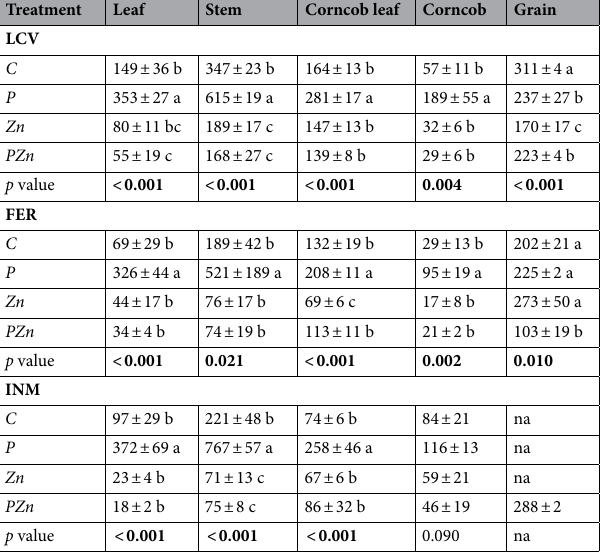
Table 3. Phosphorus to zinc mole ratio for each plant part of the maize crop at harvest (mean ± standard error, n = 4 except for grain in INM, where n = 2) as a function of treatment for each soil. Significant p values are in bold to indicate significant differences. p is the probability level of the one-way ANOVA. Different letters indicate significant differences among treatments according to the post-hoc LSD test. C : no P or Zn was added; P : fertilization with 40 mg P kg −1 but no Zn; Zn : fertilization with 3 mg Zn kg −1 but no P; PZn : fertilization with 40 mg P kg −1 and 3 mg Zn kg −1 . na: